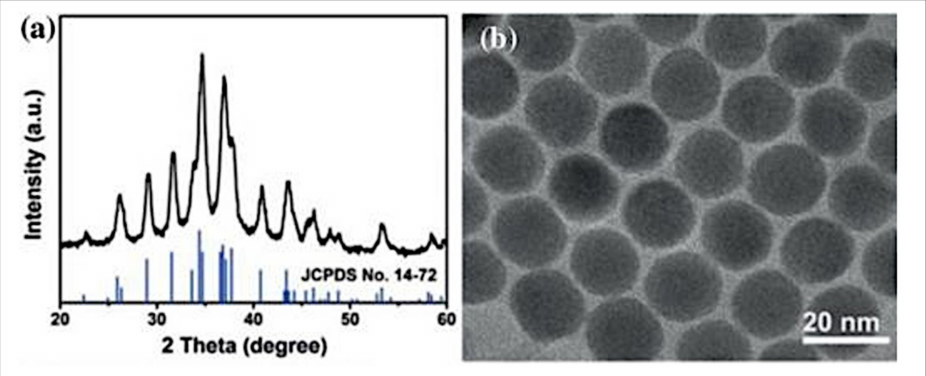
Figure 6. ( a ) XRD of the synthesized product and standard Ag 2 S (JCPDS No. 14–72) in black and blue line, respectively. and ( b ) TEM of Ag 2 S nano- crystals. Adapted with permission from reference [108]. Copyright 2022, Wiley